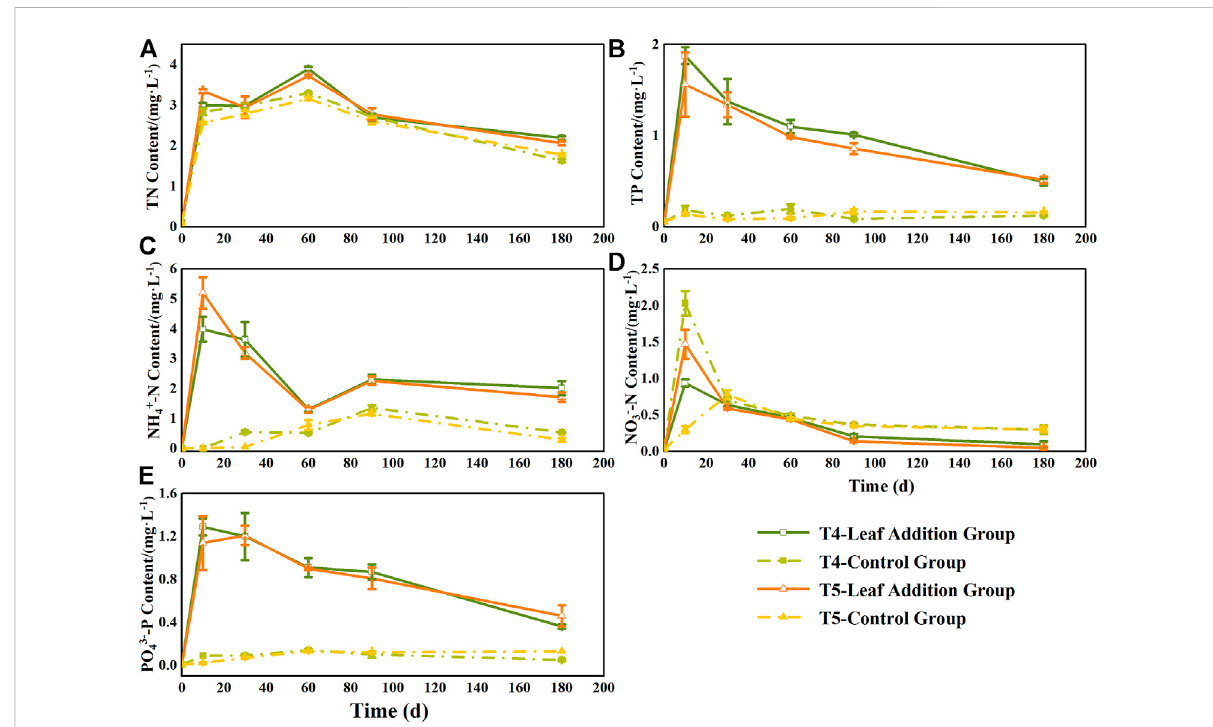
FIGURE 3 Changes in the levels of N and P in the overlying water during decomposition in Three Gorges Reservoir, China: (A) total nitrogen (TN); (B) total phosphorus (TP); (C)